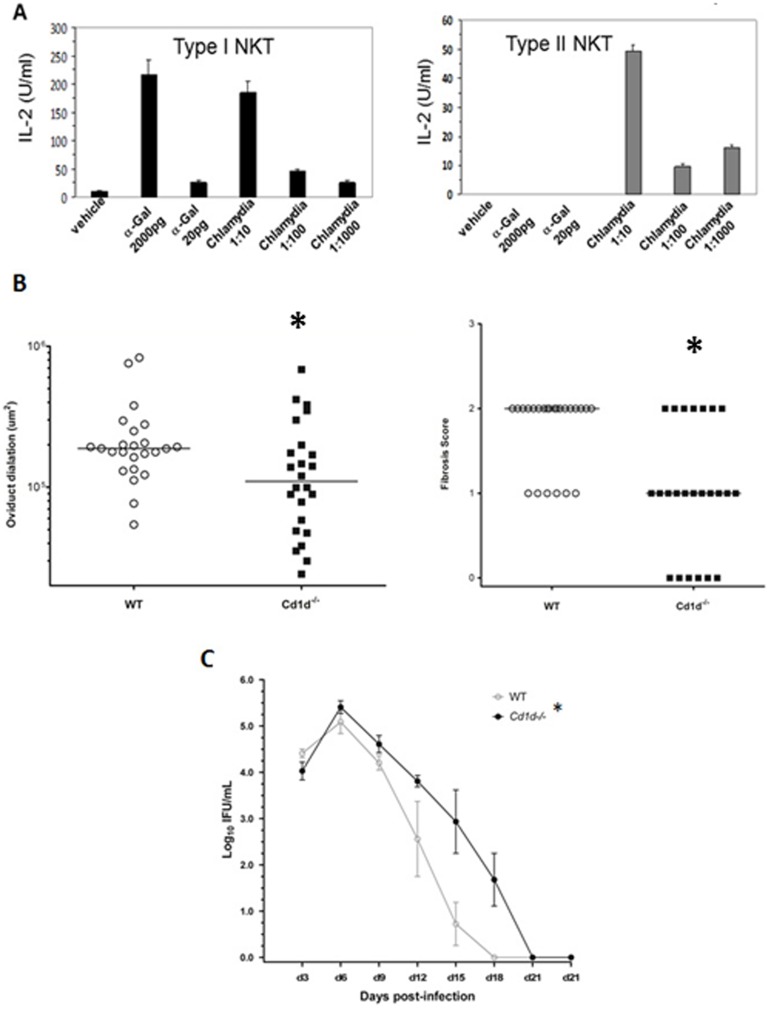

C. muridarum activates iNKT & type II NKT cells in vitro and in vivo.(A) Various dilutions of C. muridarum sonicate or α-Gal was added to cultures of type I NKT cell hybridoma 1.2 and a type II NKT cell hybridoma 1.9. IL-2 was measured in triplicate by ELISA. Experiments were and repeated 2–3 times. (B) Scatter plot of oviduct diameter and fibrosis scores from WT mice and Cxcr5−/− mice obtained from hematoxylin and eosin and trichrome stained slides, respectively. *p<0.05, Mann-Whitney, n = 6 mice or 12 oviducts/group. (C) Vaginal swabs were collected throughout the course of infection in WT and Cd1d−/− mice. *p<0.01 by 2-way repeated measures, n = 6 mice/group.